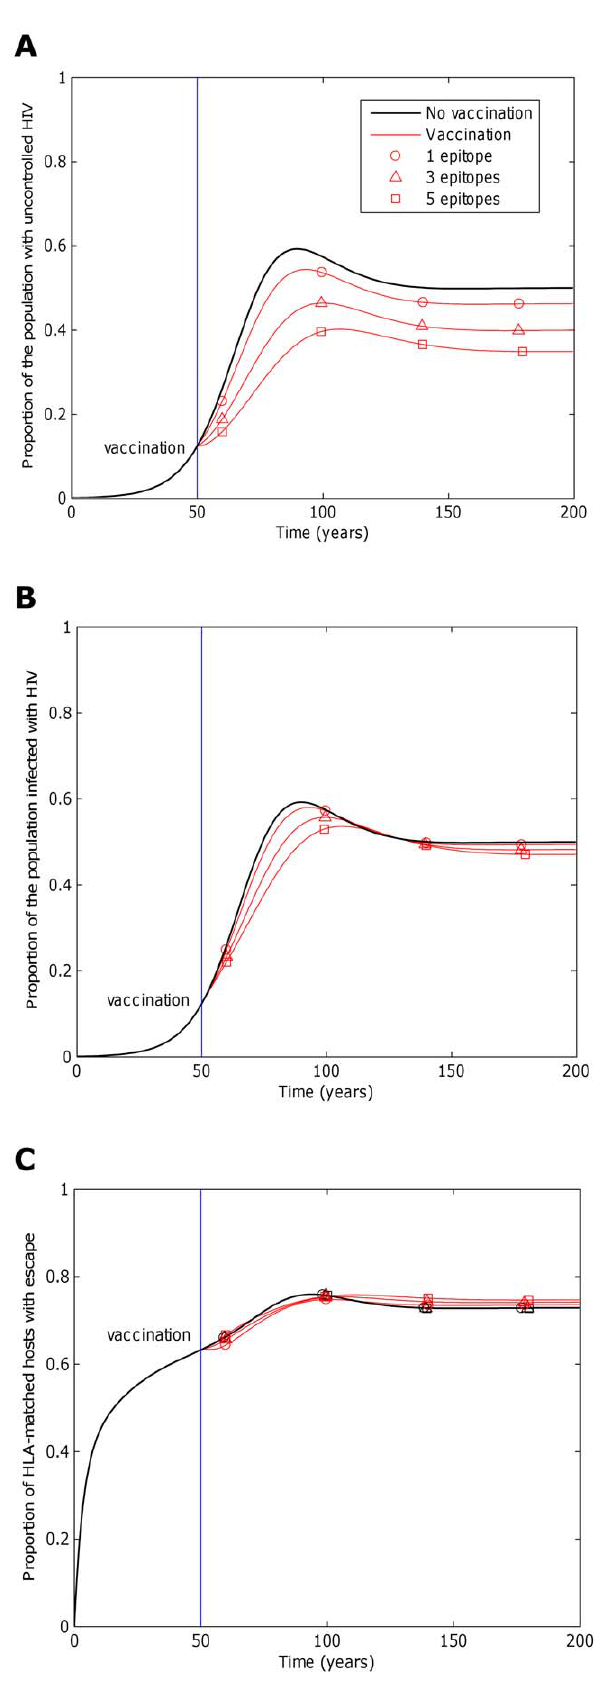
Figure 6. The impact of a vaccine would increase with vaccine breadth. This figure explores how breadth of a vaccine would affect its impact when delivered to a population 50 years into an epidemic. Model simulations are presented for vaccines that elicit responses to one epitope (circles), three epitopes (triangles) and 5 epitopes (squares). Escape takes an average of 8 years at each epitope in both vaccinated an unvaccinated hosts ( w i ~ ~ ww i ~ 1 = 8 years 2 1 for i =1:5). Reversion takes an average of 36 years at each epitope in both vaccinated